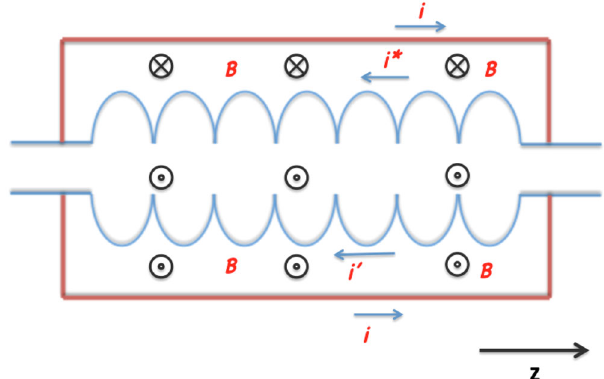
FIG. 12. Thermocurrents and associated magnetic field in the asymmetric scenario. In this case, the currents along the helium vessel are approximately equal (explained in the text) but i* and i ’ might not be equal, resulting in a field configuration with fields inside the